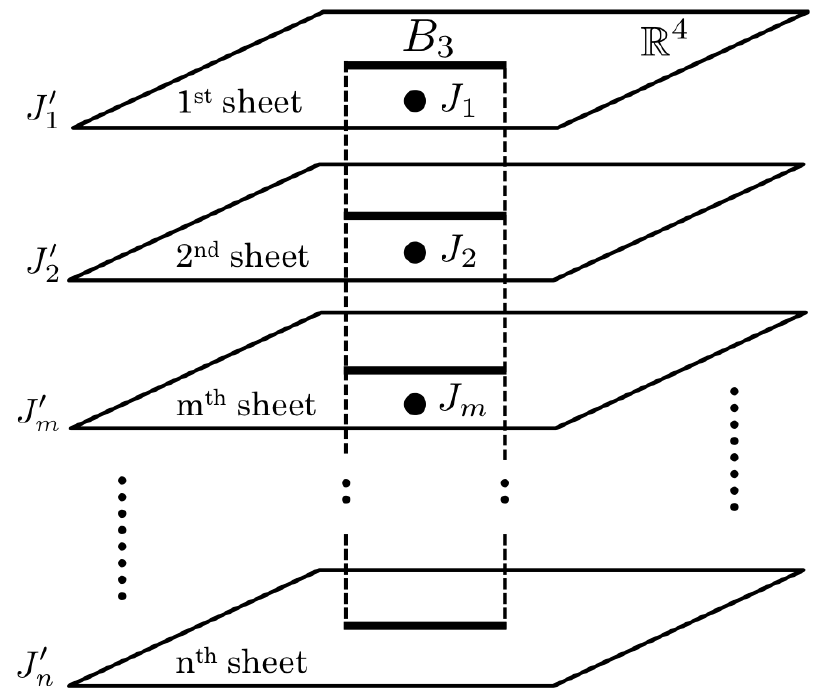
Figure 3 . m point charges in an n -sheeted Riemann space: the thick line segments and blobs are the branch three-balls and point electric charges, respectively. The branch three-balls are all identi(cid:12)ed. The number of point charges m corresponds to the number of giant gravitons at t = (cid:0)1 and the number of sheets of the Riemann space n to the number of giant gravitons at t = + 1 . the snapshots of giant gravitons at time s in the z -space are the equipotential surfaces s = (cid:30) ( z i ), and a single giant with angular momentum J corresponds to the Coulomb po- tential created by a point charge J . From (3.3) the in(cid:12)nite past and future correspond to s = + 1 and s = 0,